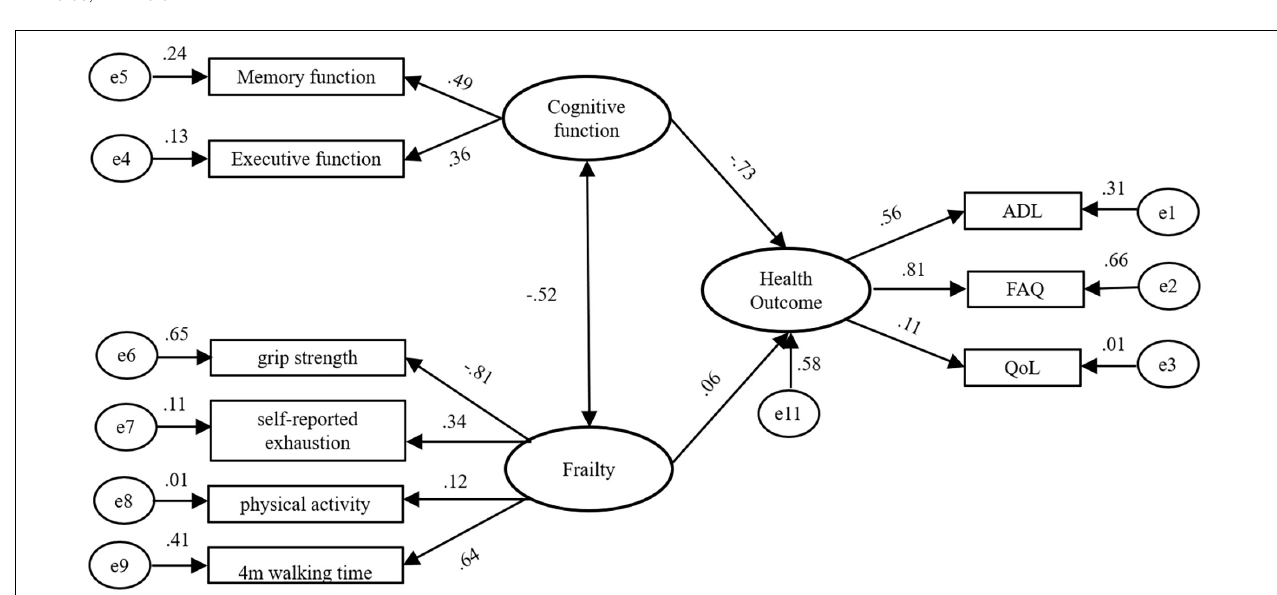
FIGURE 1 | A path diagram of direct and indirect influences of cognitive function, frailty and health outcome among community-dwelling elderly people.